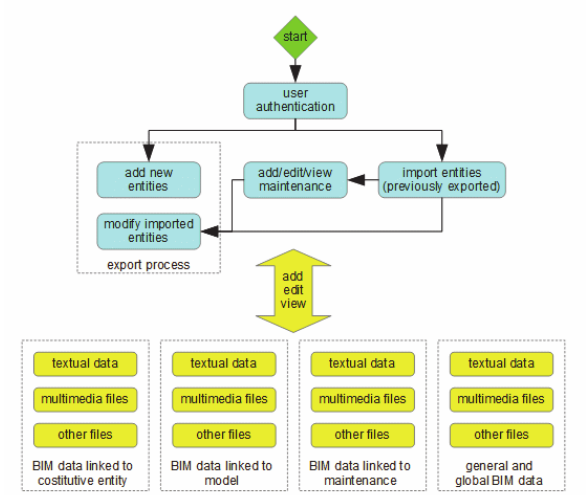
Figure 1. Block schema for the main features of